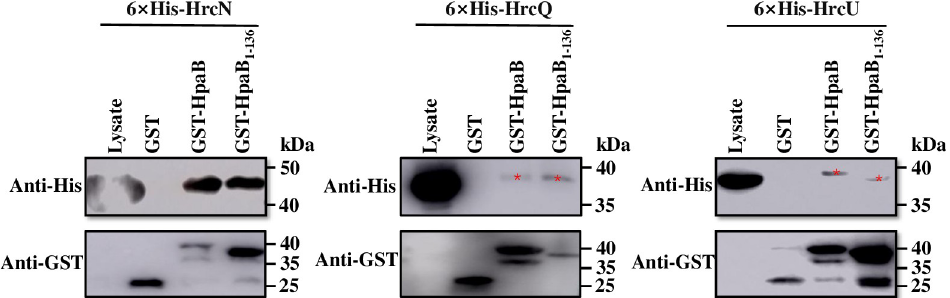
Fig 6. The C-terminal domain of HpaB is dispensable for interaction with T3SS components in Xcc . GST and GST- fused HpaB derivates were immobilized on MagneGST TM particles and incubated with cell lysates containing 6 × His- HrcN, 6 × His-HrcQ, and 6 × His-HrcU, respectively. Samples were analyzed using immunoblotting with hexahistidine- specific antibody and GST-specific antibody. The captured 6 × His-HrcQ and 6 × His-HrcU at weak level were remarked with